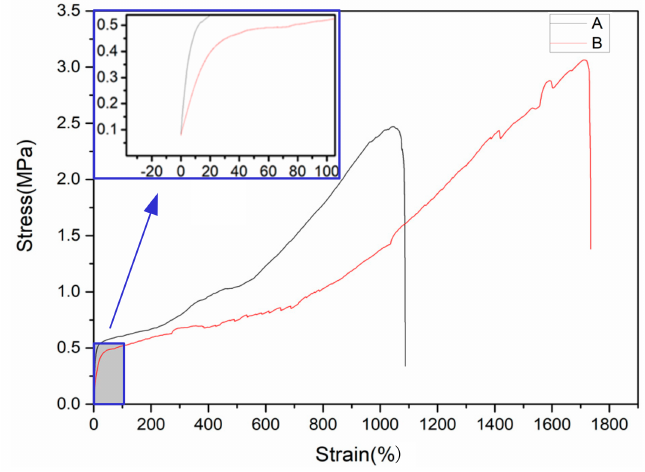
Figure 11. Stress–strain curves of the PEO-based